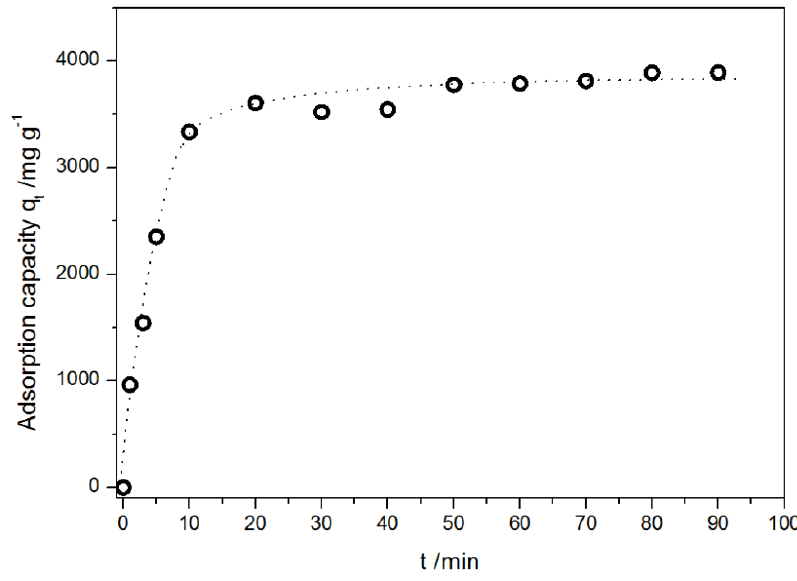
Figure 10. Kinetics of DOX adsorption on the modified MWCNTs at 298 K. Data are presented as mean ± SD ( n = 3).